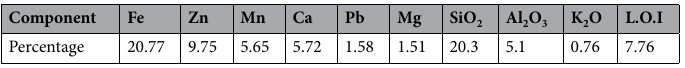
Table 1. Chemical content of the studied ore.